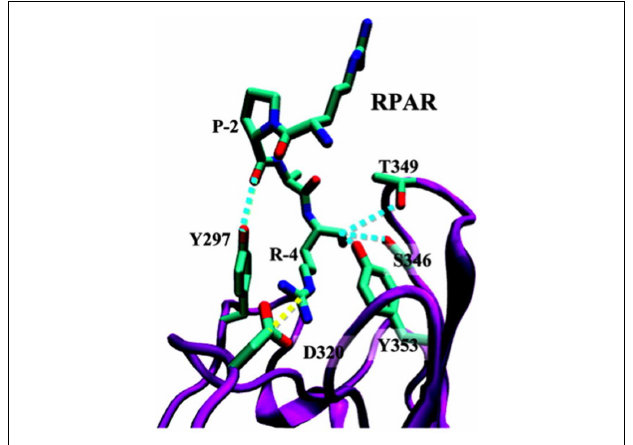
FIGURE 1 | Ribbon representation of the NRP-1-RPAR complex showing the most notable interactions found between the peptide and the binding pocket of NRP-1 .The ligand and the interacting side chains of the receptor are depicted as solid lines. NRP-1 backbone is shown in purple and RPAR backbone in green Hydrogen atoms are omitted for clarity. Specific interactions are drawn: hydrogen bonds are shown as blue discontinuous lines while salt bridges are marked by yellow discontinuous lines. Reprinted with permission from Haspel et al. (24). Copyright 2011 American Chemical